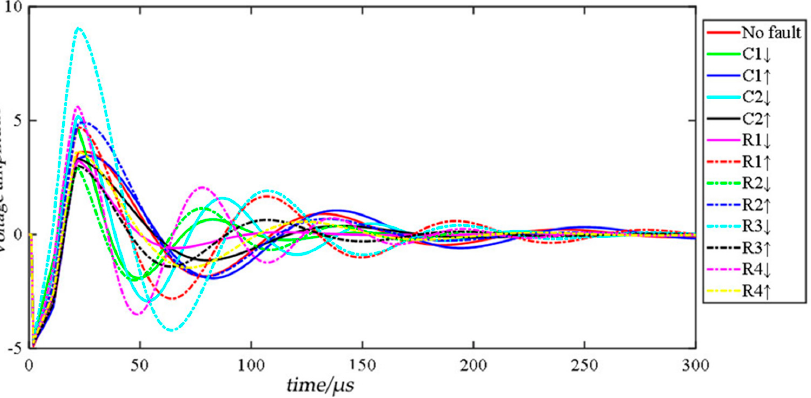
Figure 6. Output signals of different fault patterns in the Four-opamp biquad high-pass filter circuit. Table 3. Failure mode of the Four-opamp biquad high-pass filter circuit.